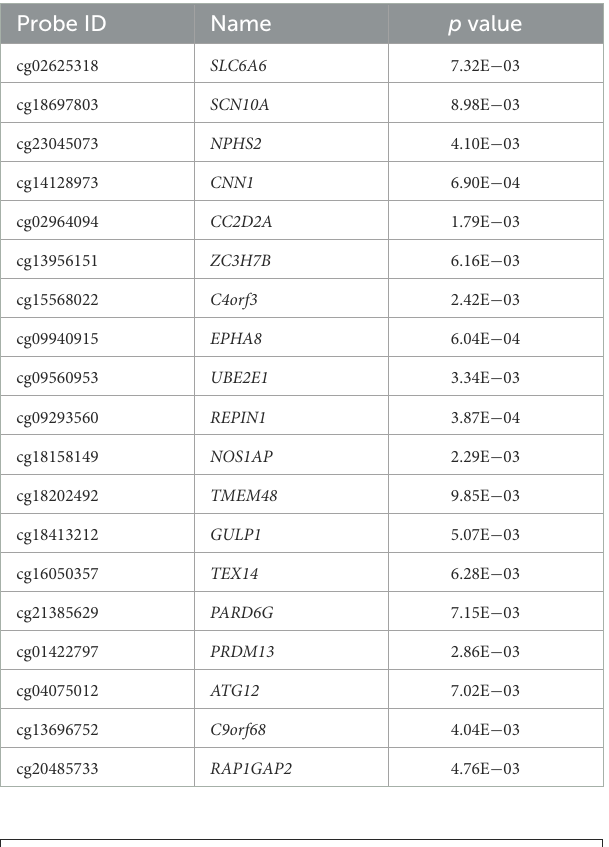
TABLE 5 Information on 19 hub genes.